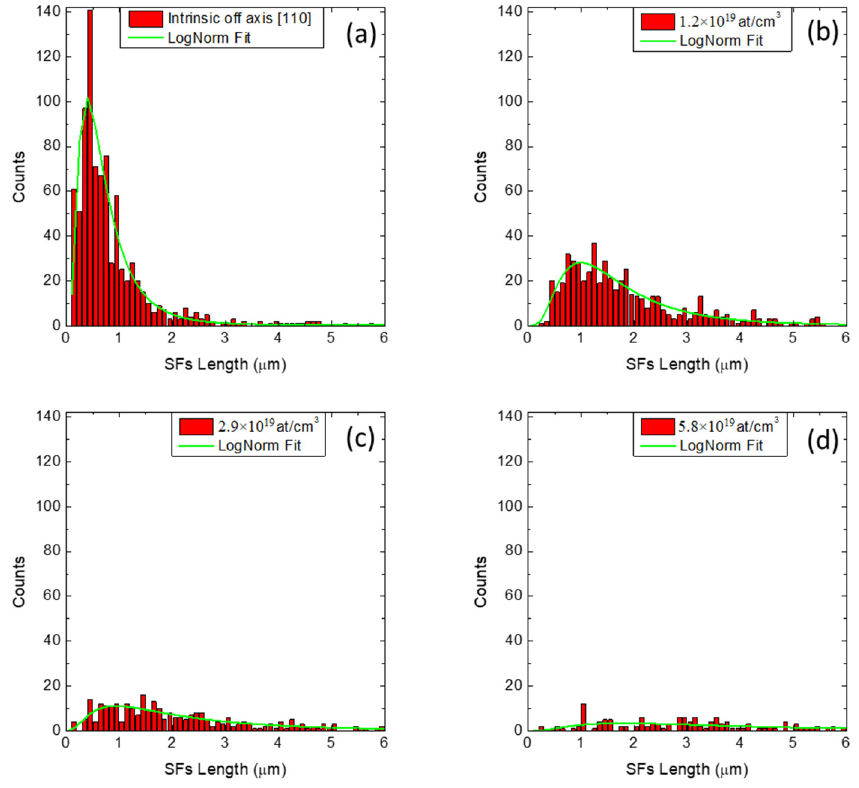
Figure 4. Length distribution of the SFs for different N-type doping. ( a ) Intrinsic sample, ( b ) 1.2 × 10 19 at/cm 3 , ( c ) 2.9 × 10 19 at/cm 3 and ( d ) 5.8 × 10 19 at/cm 3 . For all samples, there are a few SFs whose lengths are greater than the range reported in the X-axis range. However, all the lengths of the SFs were considered in the calculation of the mean lengths and densities. The distributions of the lengths of the SFs were fitted with log-normal type curves, which are better suited to fit the experimental values and to reduce the fit error. From the fits, the mean values of length of the SFs were obtained for all the samples. The values are reported in Table 1 and they are plotted in Figure 6. Table 1. Values of average lengths and densities for different doping concentrations.